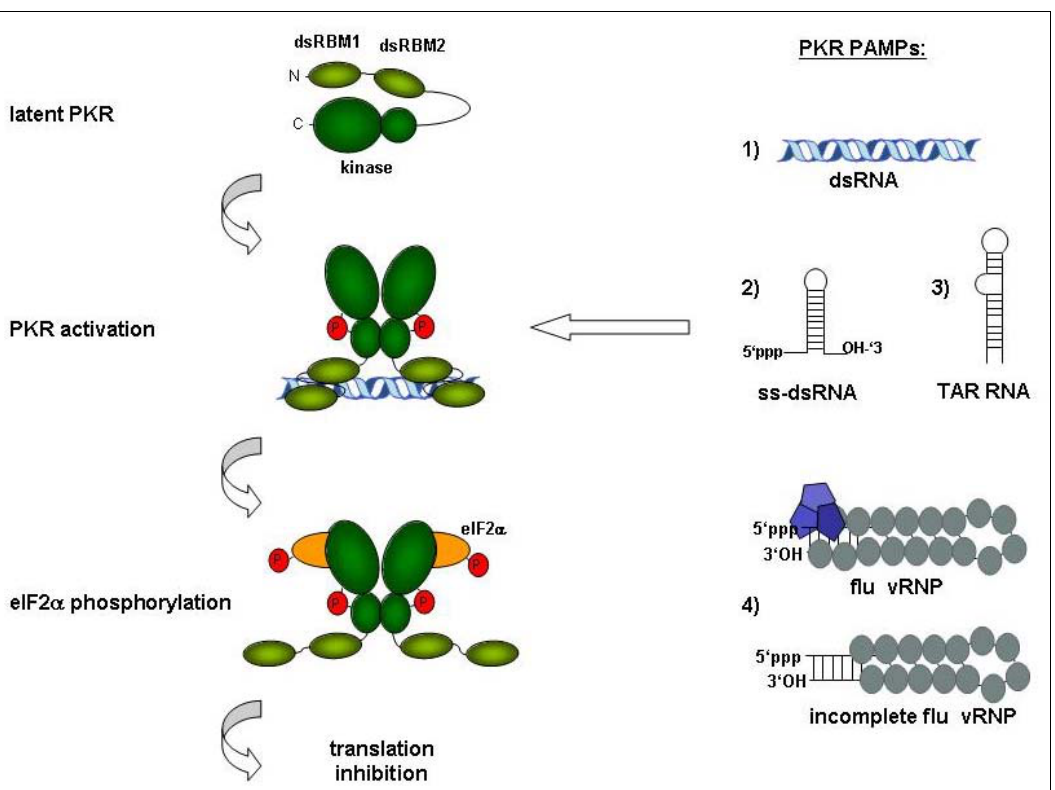
Figure 1. Activation of PKR by different viral and synthetic RNAs. Latent PKR binds to (1) perfect dsRNA of viral or synthetic origin, (2) synthetic structured RNA with single stranded tails and a 5’triphosphate, (3) HIV-1 TAR RNA or (4) (possibly incomplete) influenza virus vRNP. This leads to dimerization and autophosphorylation of PKR. Active PKR then phosphorylates its substrate eIF2  , which results in a block of translation. PKR consists of two dsRNA-binding motifs (dsRBM1 + dsRBM2 in light green) and the N -terminal and C -terminal lobe of the kinase domain (dark